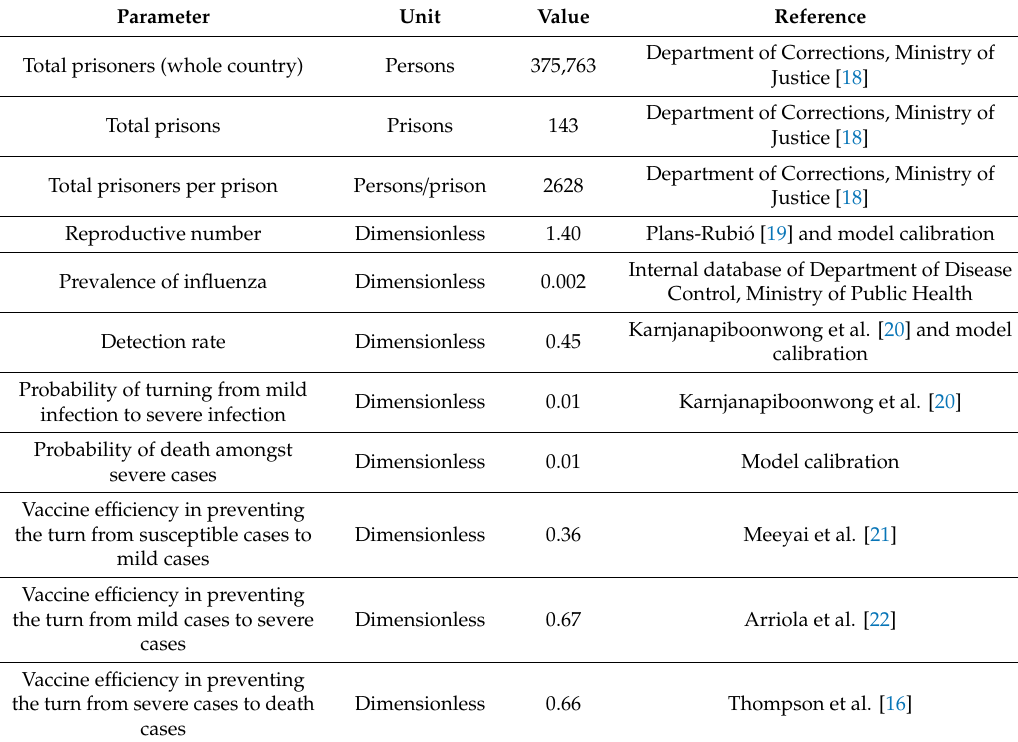
Table 2. Key parameter